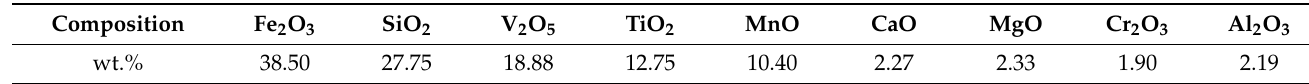
Table 2. Chemical composition of the vanadium slag used in this